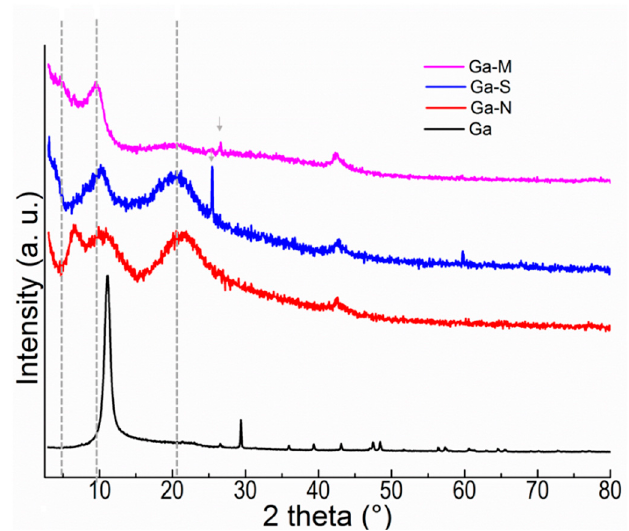
Figure 3. XRD diffractograms of the pristine and functionalized Ga samples. Figure 3. XRD di ff ractograms of the pristine and functionalized Ga